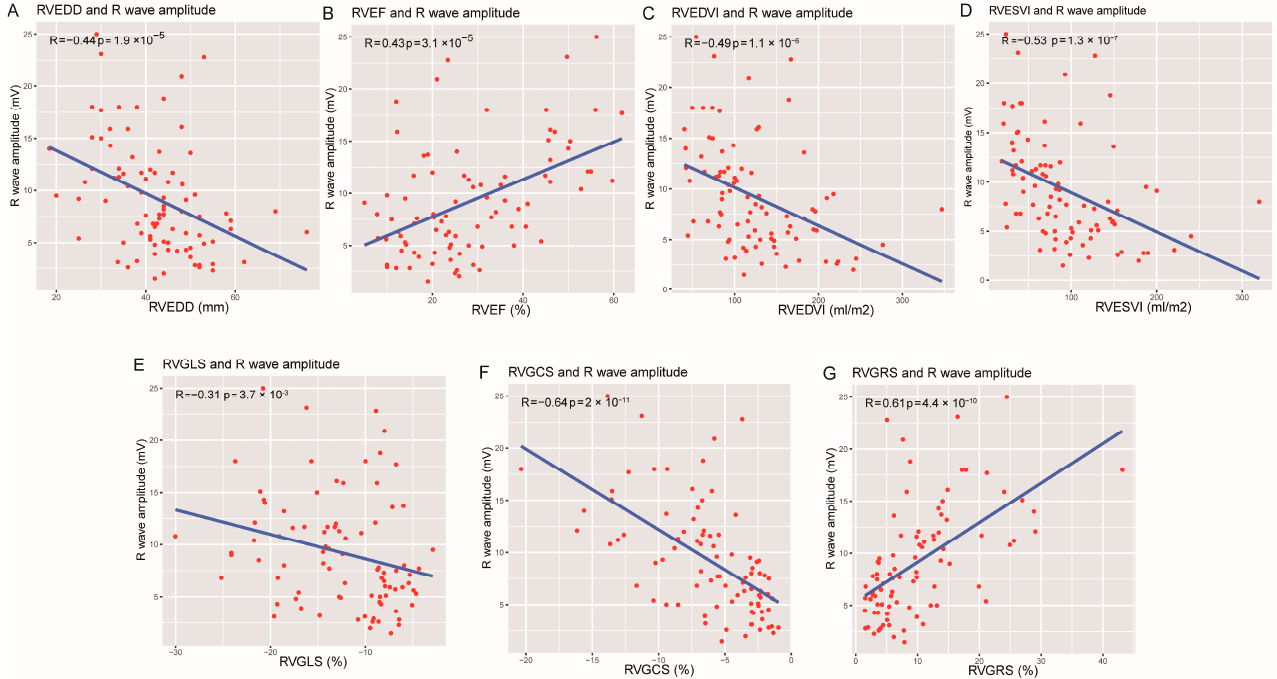
Figure 2. The linear relationship between right ventricular structural, functional strain parameters, and R wave amplitude. ( A – D ) Correlation between right ventricular (RV) ejection fraction, RV end-diastolic diameter, RV end-diastolic volume index, RV end-systolic volume index, and R wave amplitude (RWA) of ICD lead. ( E – G ) Correlation between RV global longitudinal, circumferential and radial strain, and RWA. Table 4. Imaging parameters for predicting Low